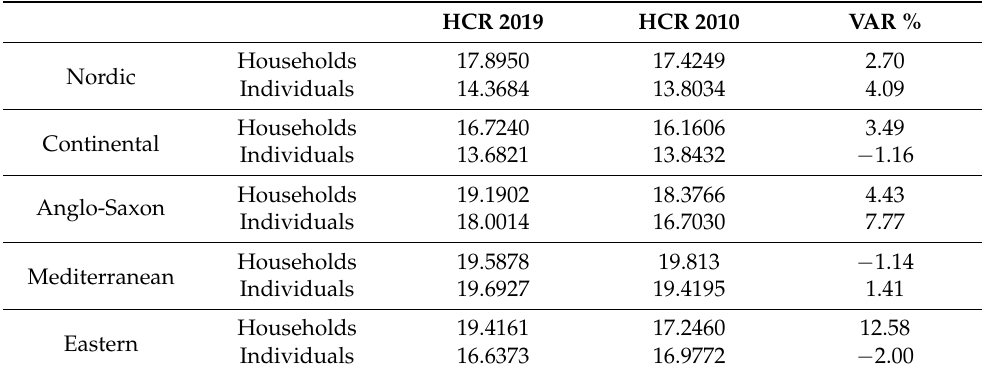
Table 2. Percentage of individuals and households in poverty in 2010 and 2019.